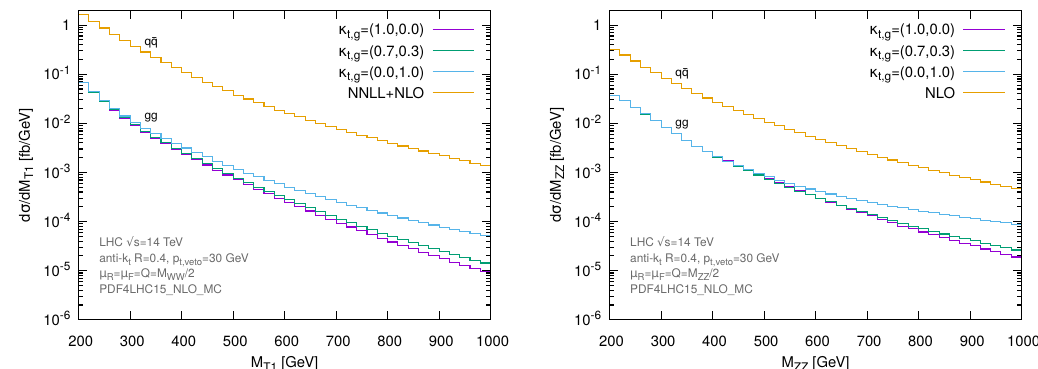
Figure 11 . Our best predictions for the di(cid:11)erential distributions d(cid:27)=dM T 1 for WW production with the experimental cuts in table 1 (left) and d(cid:27)=dM ZZ for ZZ production with the cuts in ref. [88] (right) for q (cid:22) q and gg